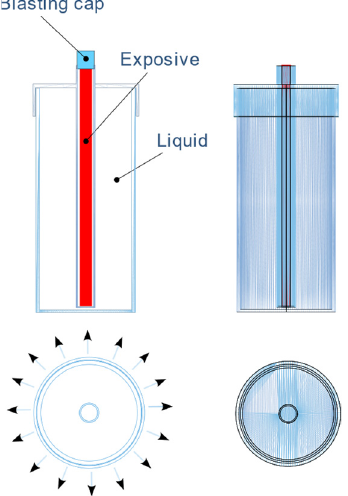
Figure 2. Basic sketch of the omnidirectional water projection device.